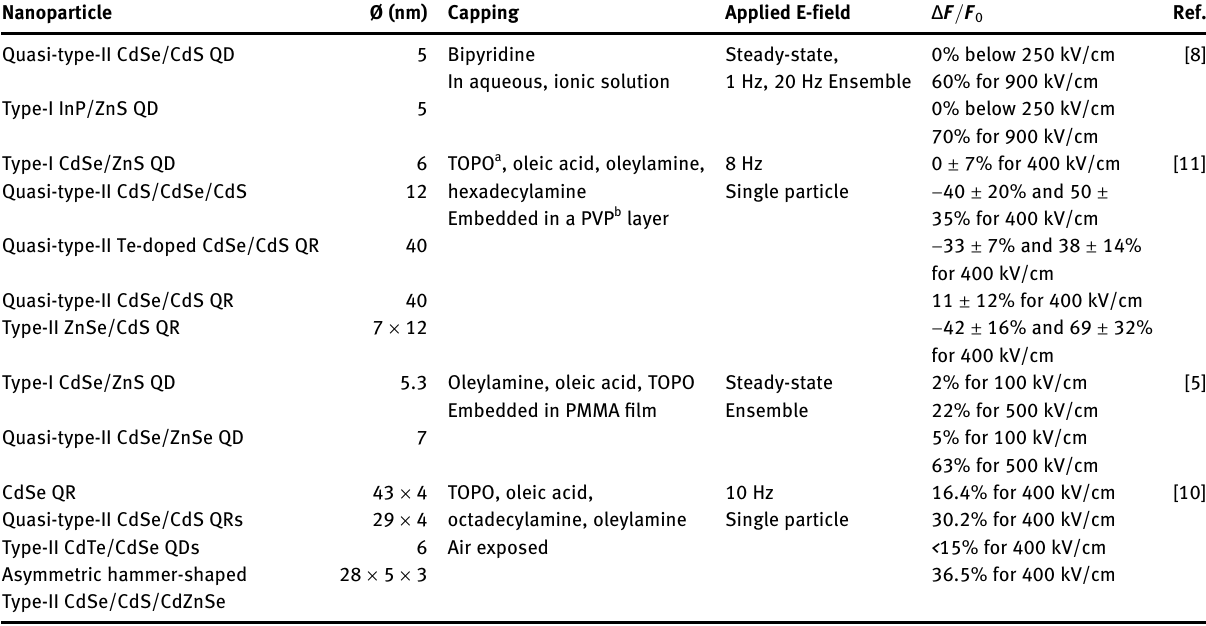
Table  : Literature reports on QCSE-based E- fi eld sensitivity of QD/QR  PF intensity by application of well-controlled E- fi